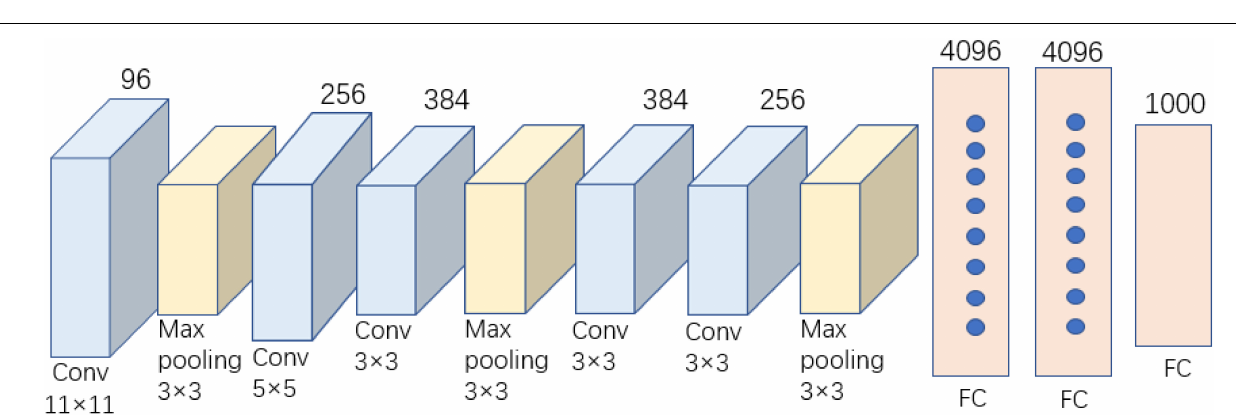
FIGURE 2 | Sketch of the AlexNet model